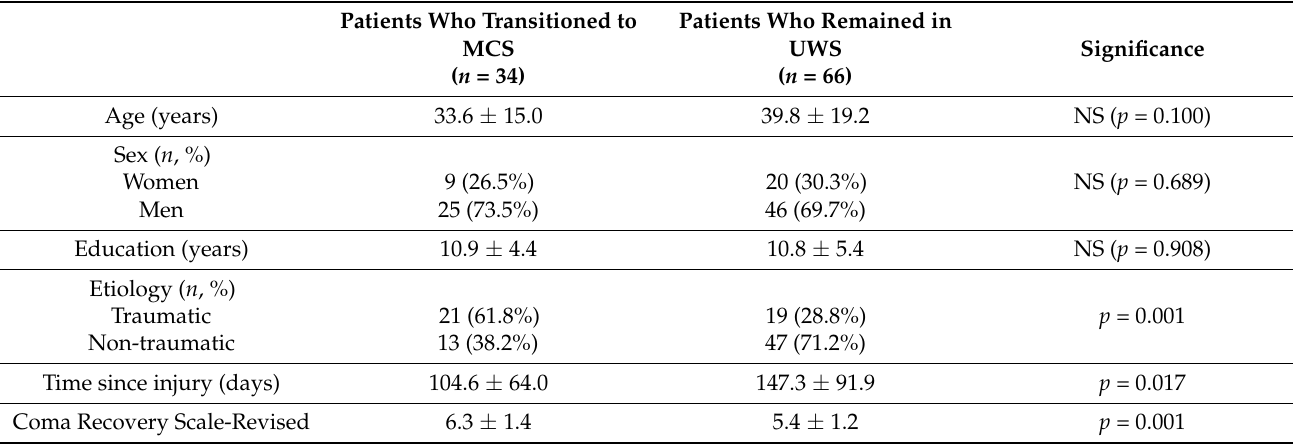
Table 1. Baseline demographic and clinical characteristics of the patients who did and did not transition to Minimally Conscious State.